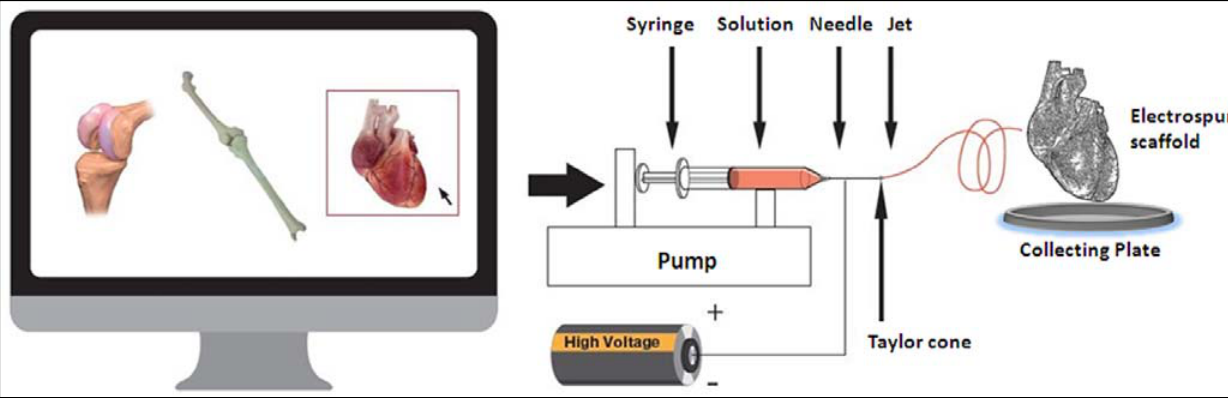
Figure 2. Schematic diagram of the electrospinning process showing a glass syringe containing polymer solution; a nanofiber jet; a copper collecting plate and a power